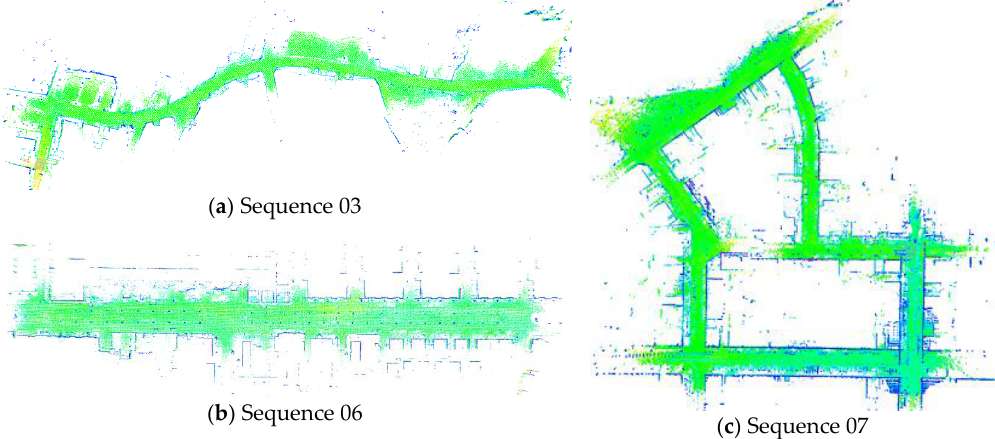
Figure 10. The mapping results in the three sequences.